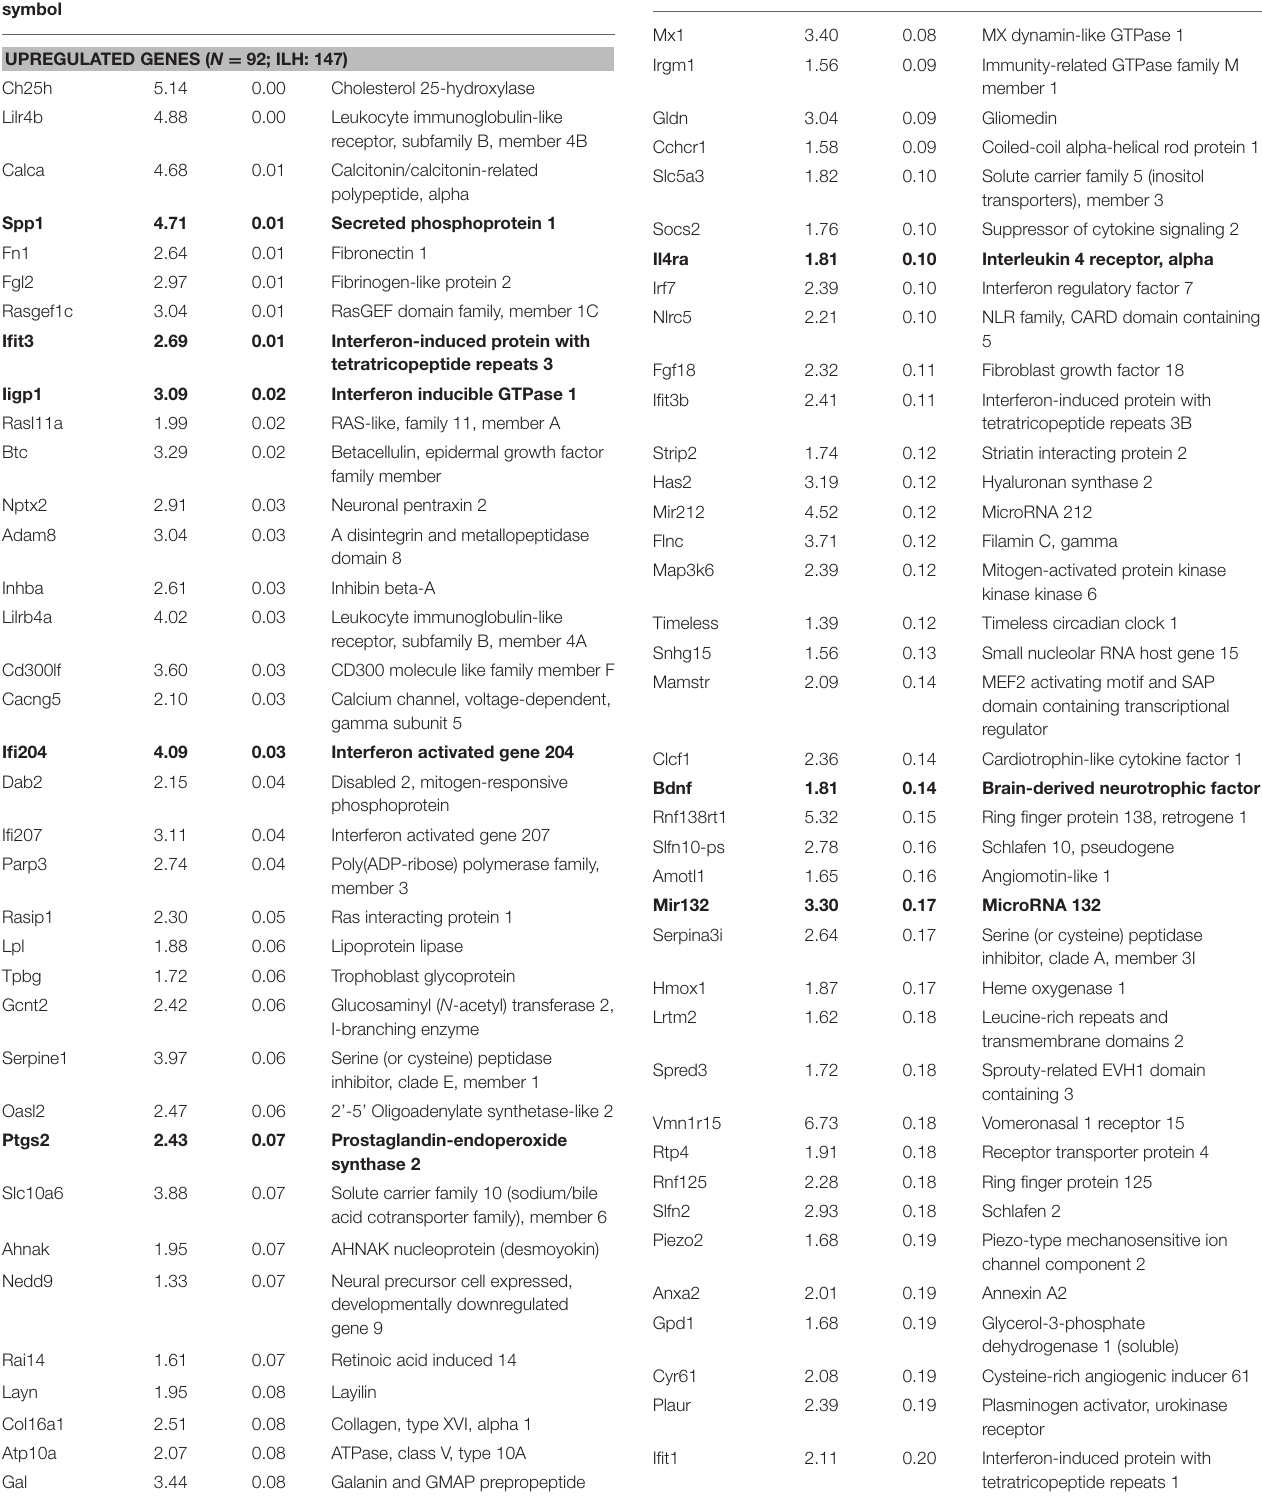
TABLE 6 | Differentially expressed genes in glia exclusively in the ILH (and not CLH) at 24h after kainate-induced status epilepticus. Gene